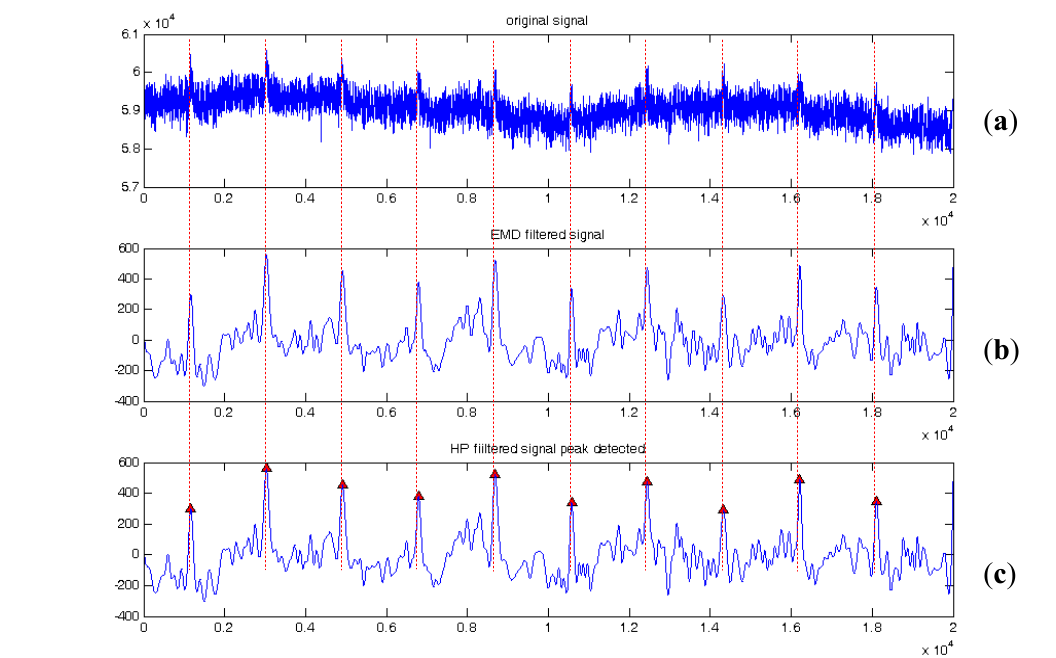
Figure 6. Subject 3 ( a ) shows 10 s of lead 1, ( b ) shows the signal across the bicep post EMD filter, ( c ) shows the output post HP